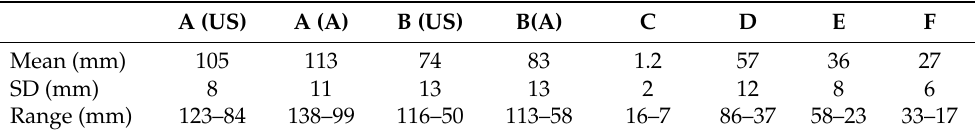
Figure 1. D (deltoideus muscle), BB (biceps brachii muscle), BR (brachioradialis muscle), B (brachialis muscle), LHTB (lateral head of the triceps brachii), ECRL (extensor carpi radialis longus muscle), LIMS (lateral intermuscular septum), RN (radial nerve), PACN (posterior antebrachial cutaneous nerve), A-PACN (anterior branch of the PACN), P-PACN (posterior branch of the PACN) and LE (lateral epicondyle). Arrow A : Distance from the LE to the point where the RN pierces the LIMS. Arrow B : Distance from the LE to the hiatus where the PACN pierces the deep fascia. Point C: PACN diameter in the point where the nerve pierces the deep fascia in the arm. Arrow D : Distance from the LE to the bifurcation of the PACN in the A-PACN and P-PACN. Table 1. Ultrasonographyc (US)/Anatomic (A) diameter/distance of the different landmarks between the RN and PACN to LE.